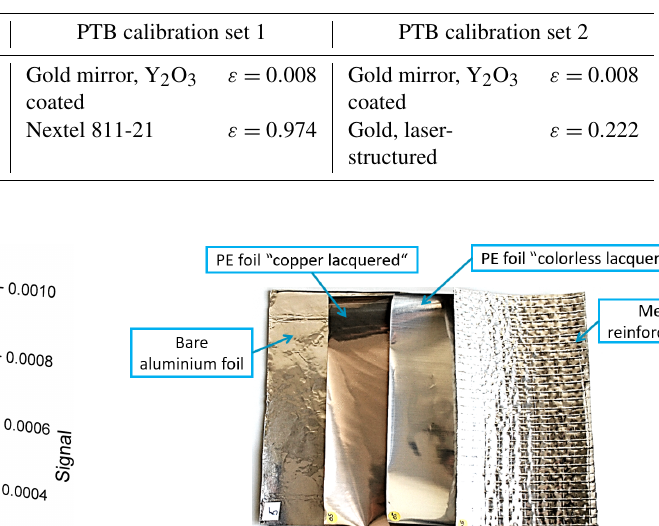
Table 3. The applied reference samples’ directional total emissivity values for the three calibration sets of the TIR 100-2.